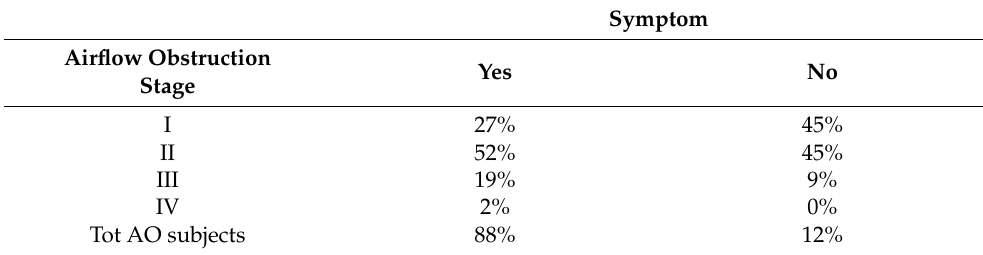
Table 6. Prevalence of studied variables for AO with and without symptoms.